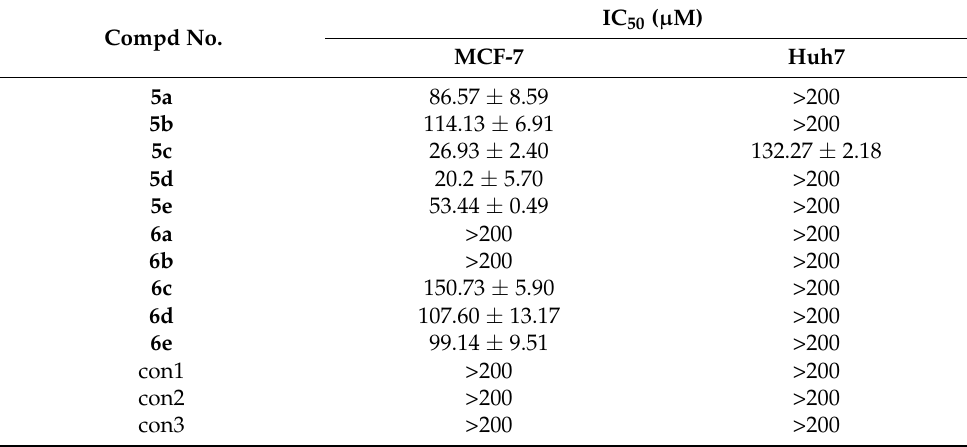
Table 1. Cell toxicity and viability of compounds 5a – 5e and 6a – 6e . Compd